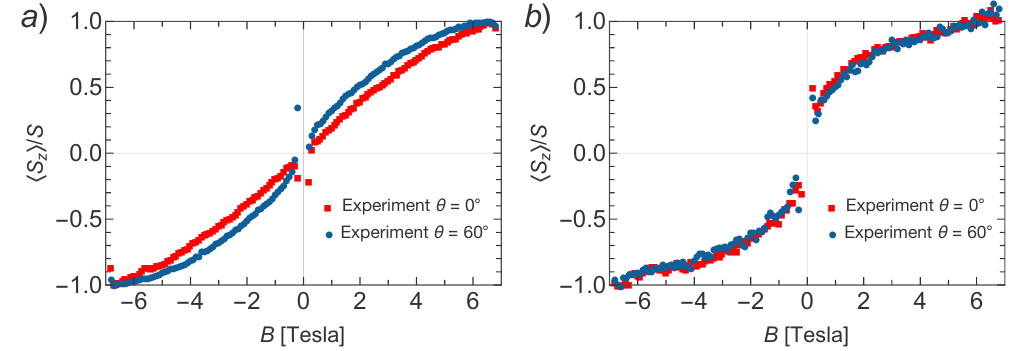
Figure 4. Comparison of the rescaled X-ray magnetic circular dichroism (XMCD) signal measured for ( a ) Mn–TCNQ and ( b ) Ni–TCNQ at normal ( θ = 0 ◦ ) and grazing ( θ = 60 ◦ ) beam incidences. The data in ( a ) show a sizable θ -dependence, which we attribute to the single-ion anisotropy for Mn–TCNQ. In contrast, the data in ( b ) show no θ -dependence, meaning that there exists no sizable magnetic